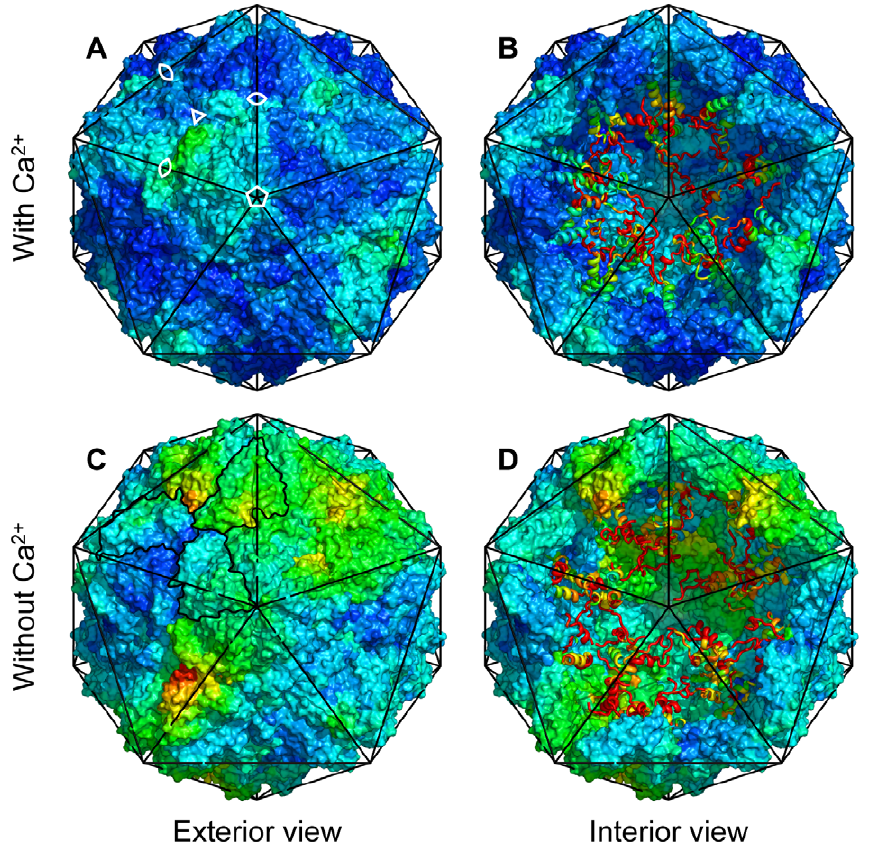
Figure 3. Structural changes of the capsid. Van der Waals surfaces of the capsid shell after 1 m s viewed along one of the 5-fold symmetry axes. Top row ( A, B ) shows Sim Ca D neut and bottom row ( C, D ) shows Sim NoCa D neut . Right column ( B, D ) shows the interior structure when the 15 frontmost proteins has been removed. Each capsid inscribed in an icosahedron with 22 nm between opposing vertices. The N-terminal domains are represented as ribbons. Colors according to the RMSd from the crystal structure. The color scale goes from blue (0.0 nm) through cyan, green, lime- green, yellow and red ( § 1 : 0nm ). Location of symmetry axes marked for one icosahedral face in ( A ). The outline of the proteins in one trimer traced in ( C ).